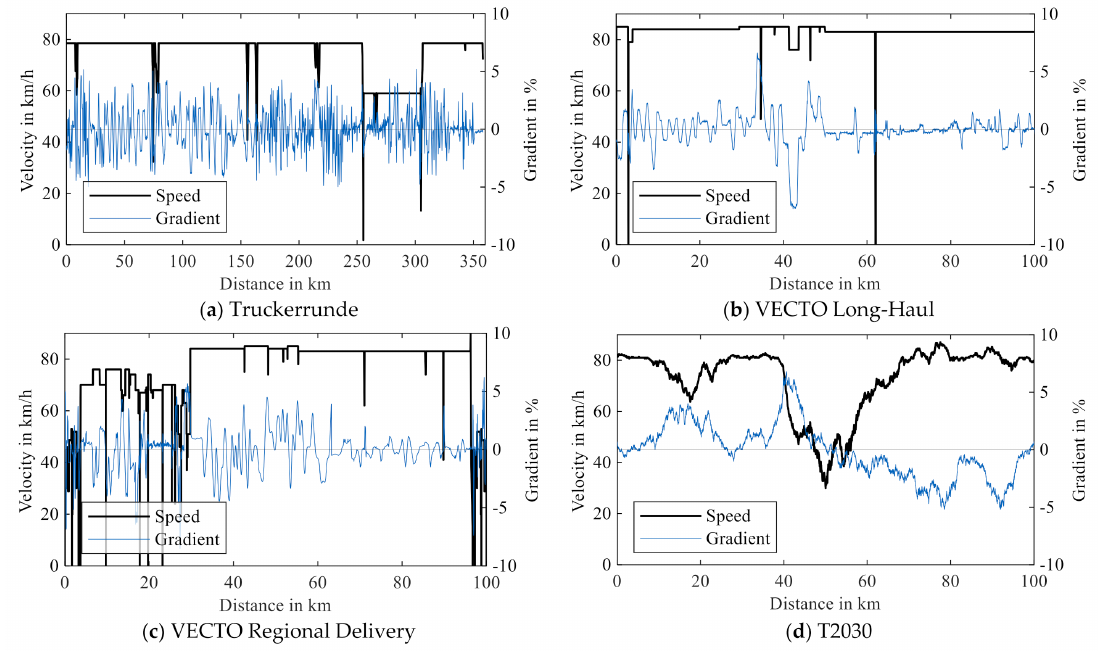
Figure 2. Speed profile and road gradient of different driving cycles ( a – d ). Truckerrunde is based on a real road-profile, while the other driving cycles are synthetic driving cycles based on collected and processed driving